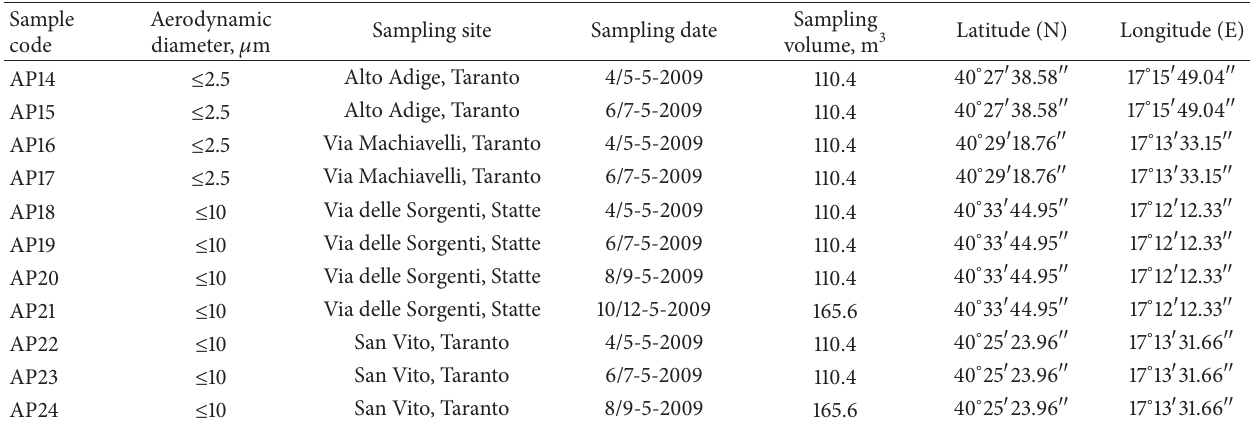
Table 3: Characteristics of the sampling sites for atmospheric particulate (AP) collected in the sampling campaign of May 2009.